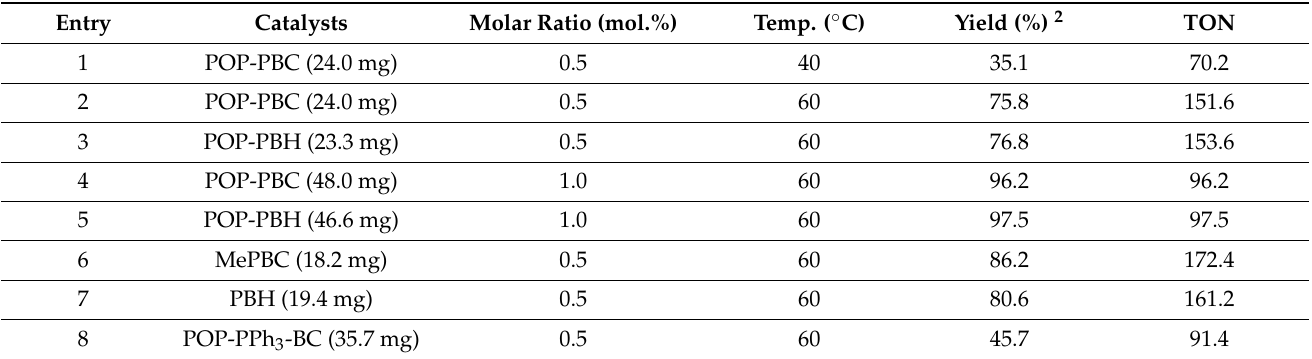
Table 1. Catalytic performance of different catalysts in the cycloaddition of CO 2 with epichlorohydrin to form cyclic carbonate 1 .